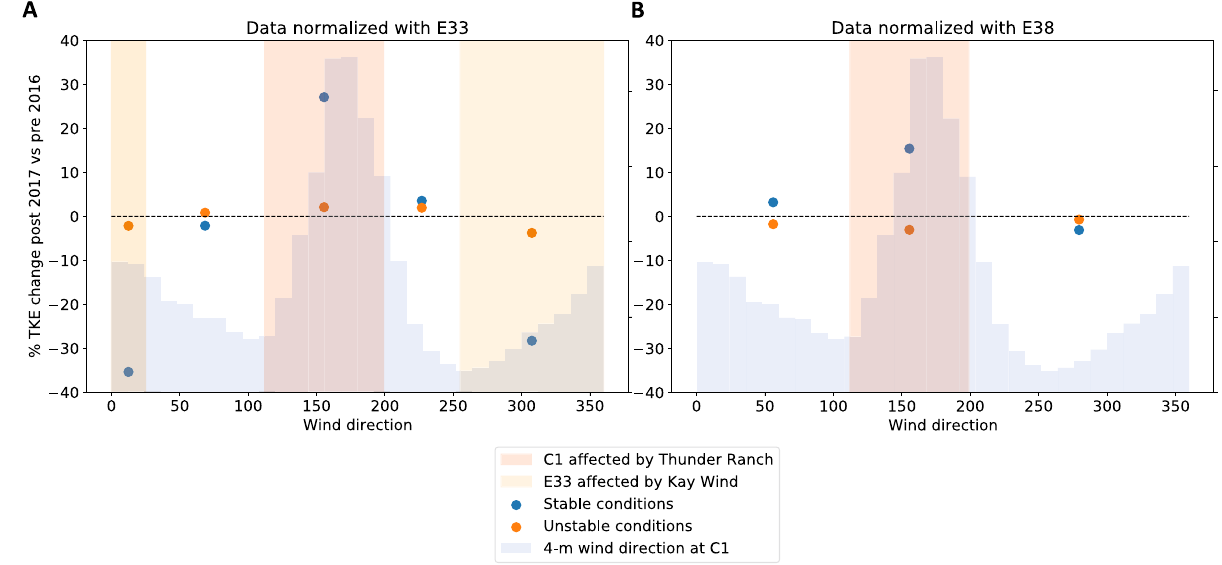
Figure 6. ( A , B ) Median percentage change in 4-m TKE when comparing post- and pre-wind plant observations as a function of wind direction. Data at C1 are normalized according to Eq. (2) (but applied to TKE instead of wind speed) using observations at E33 ( A ) and E38 ( B ). In each panel, the background blue shading indicates the wind direction